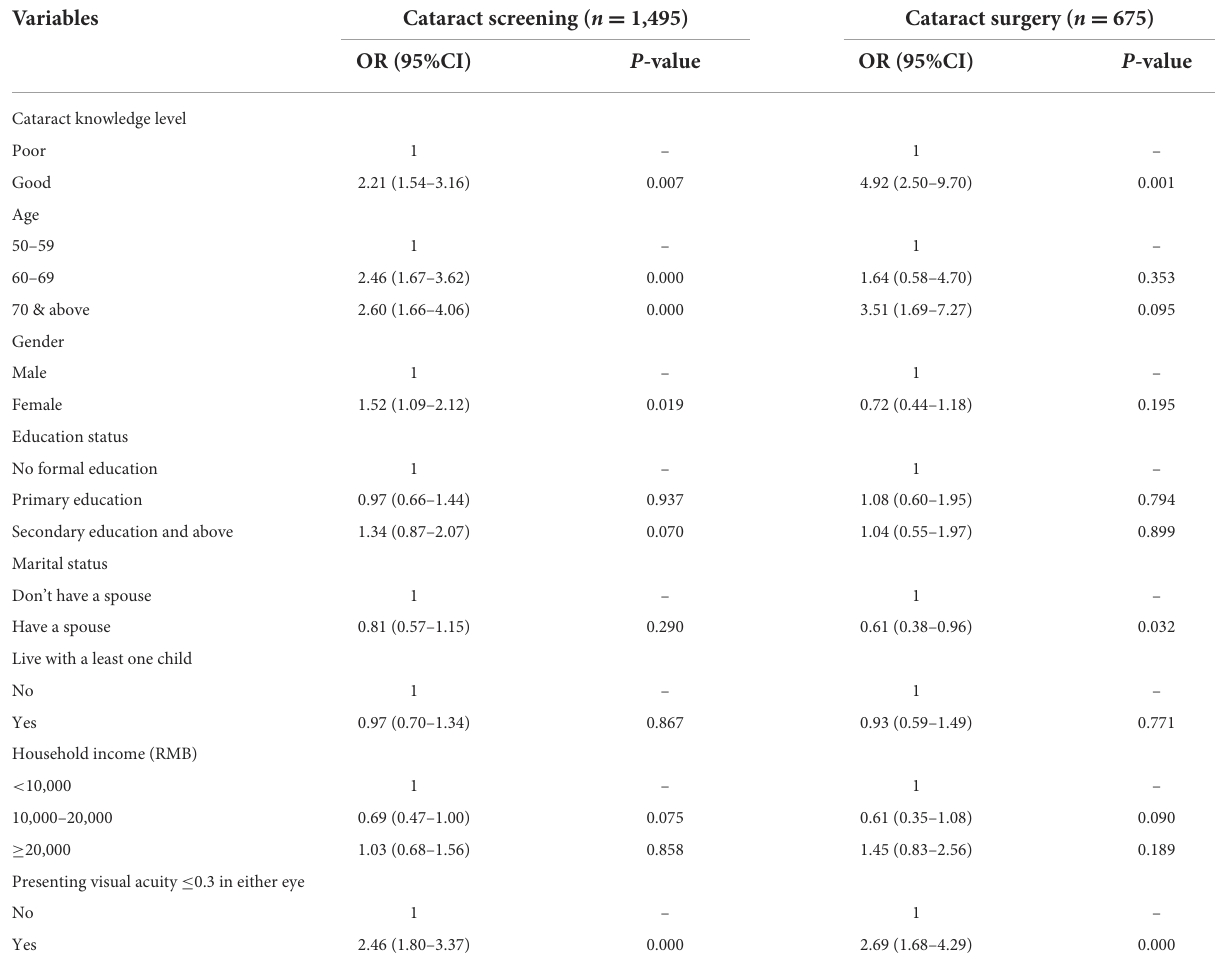
TABLE 4 Multivariate estimation of the association of knowledge level about cataracts with eye care